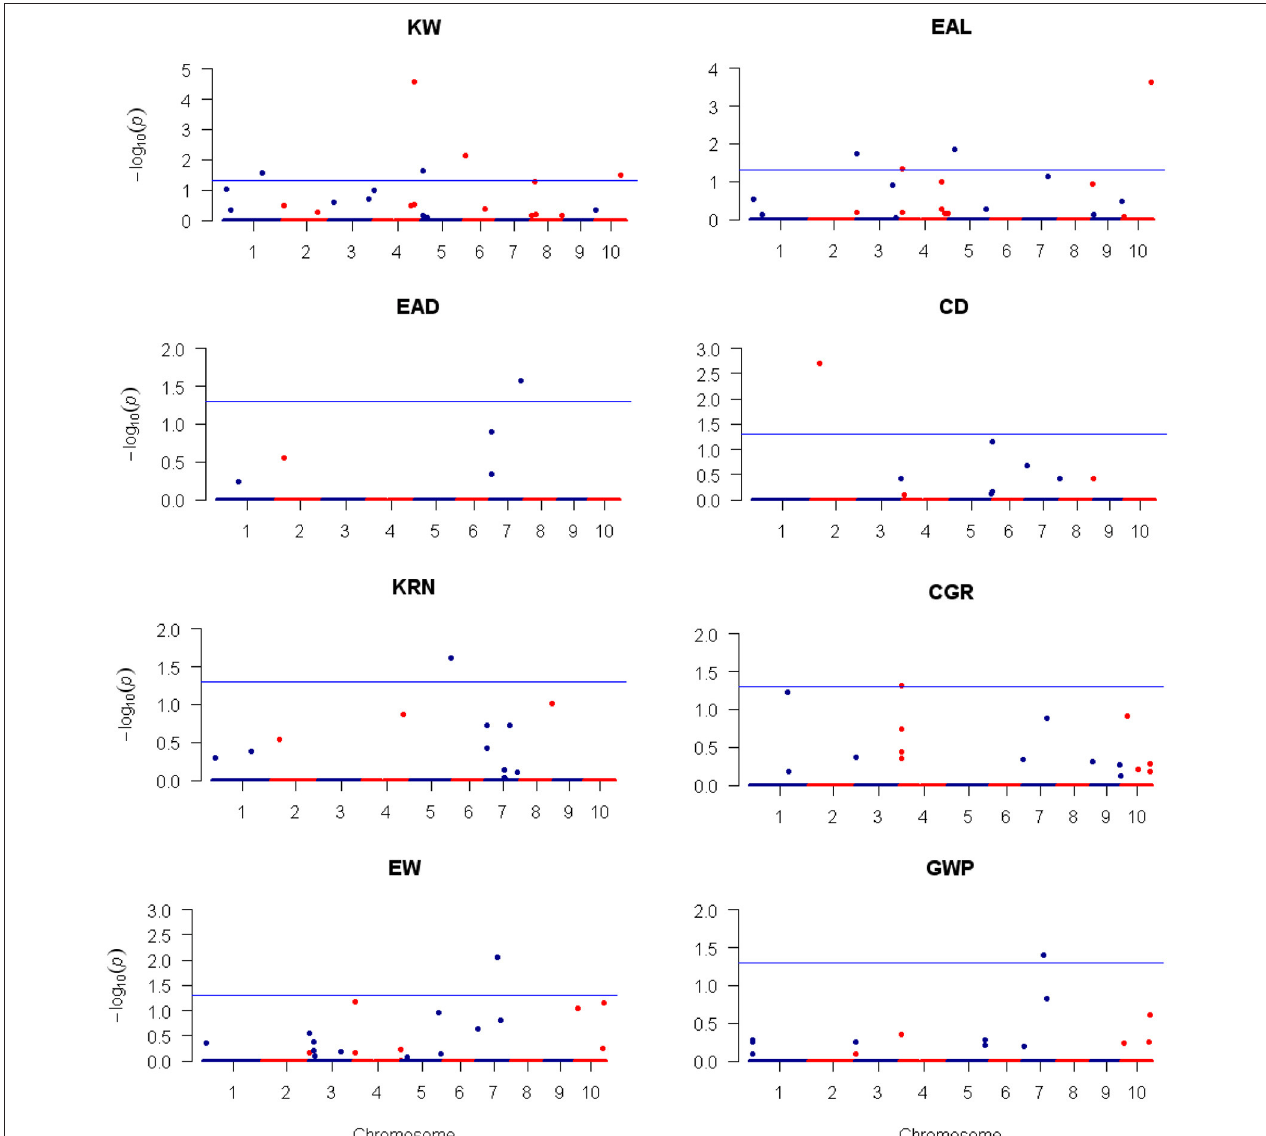
FIGURE 6 | Plots of the dominance effect test statistic − Log10( p ) against genome location for eight traits of maize using the LASSO method. The horizontal blue line is the critical value of the test statistic at the nominal level of − Log10(0.05) = 1.3. Note that LASSO is a multiple marker model and no adjustment for the critical value of test statistic is